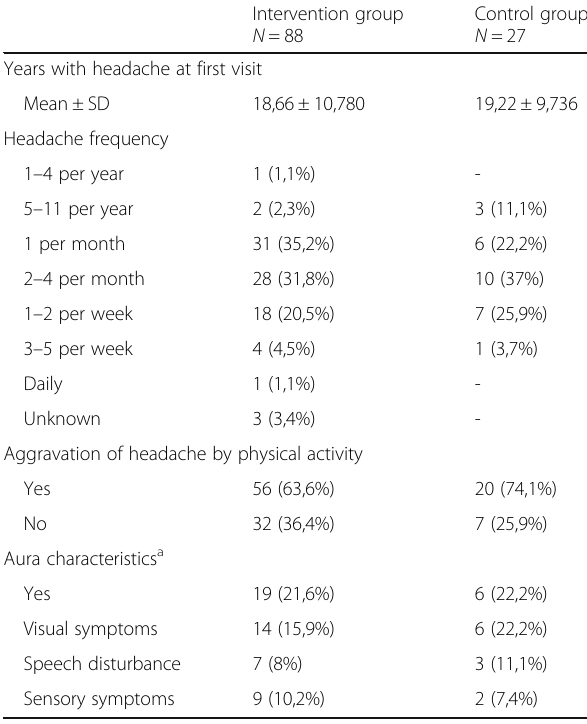
Table 1 Baseline characteristics of patients, n (%)